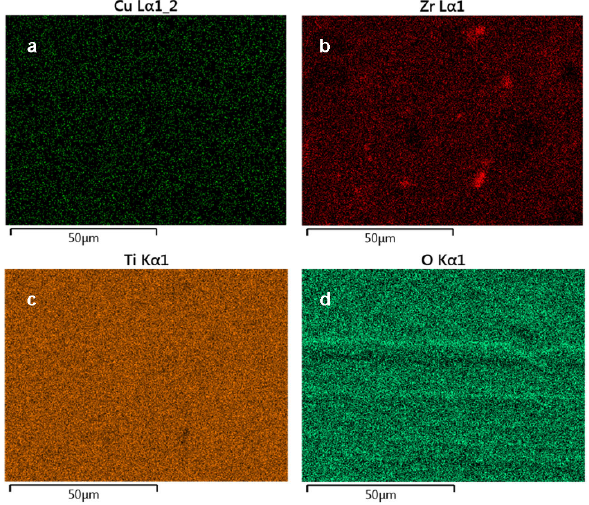
Figure 5. STEM-EDX mapping of Cu- and Zr-modified TiO 2 /Cu (0.05%)/Zr (1%) photocatalyst.